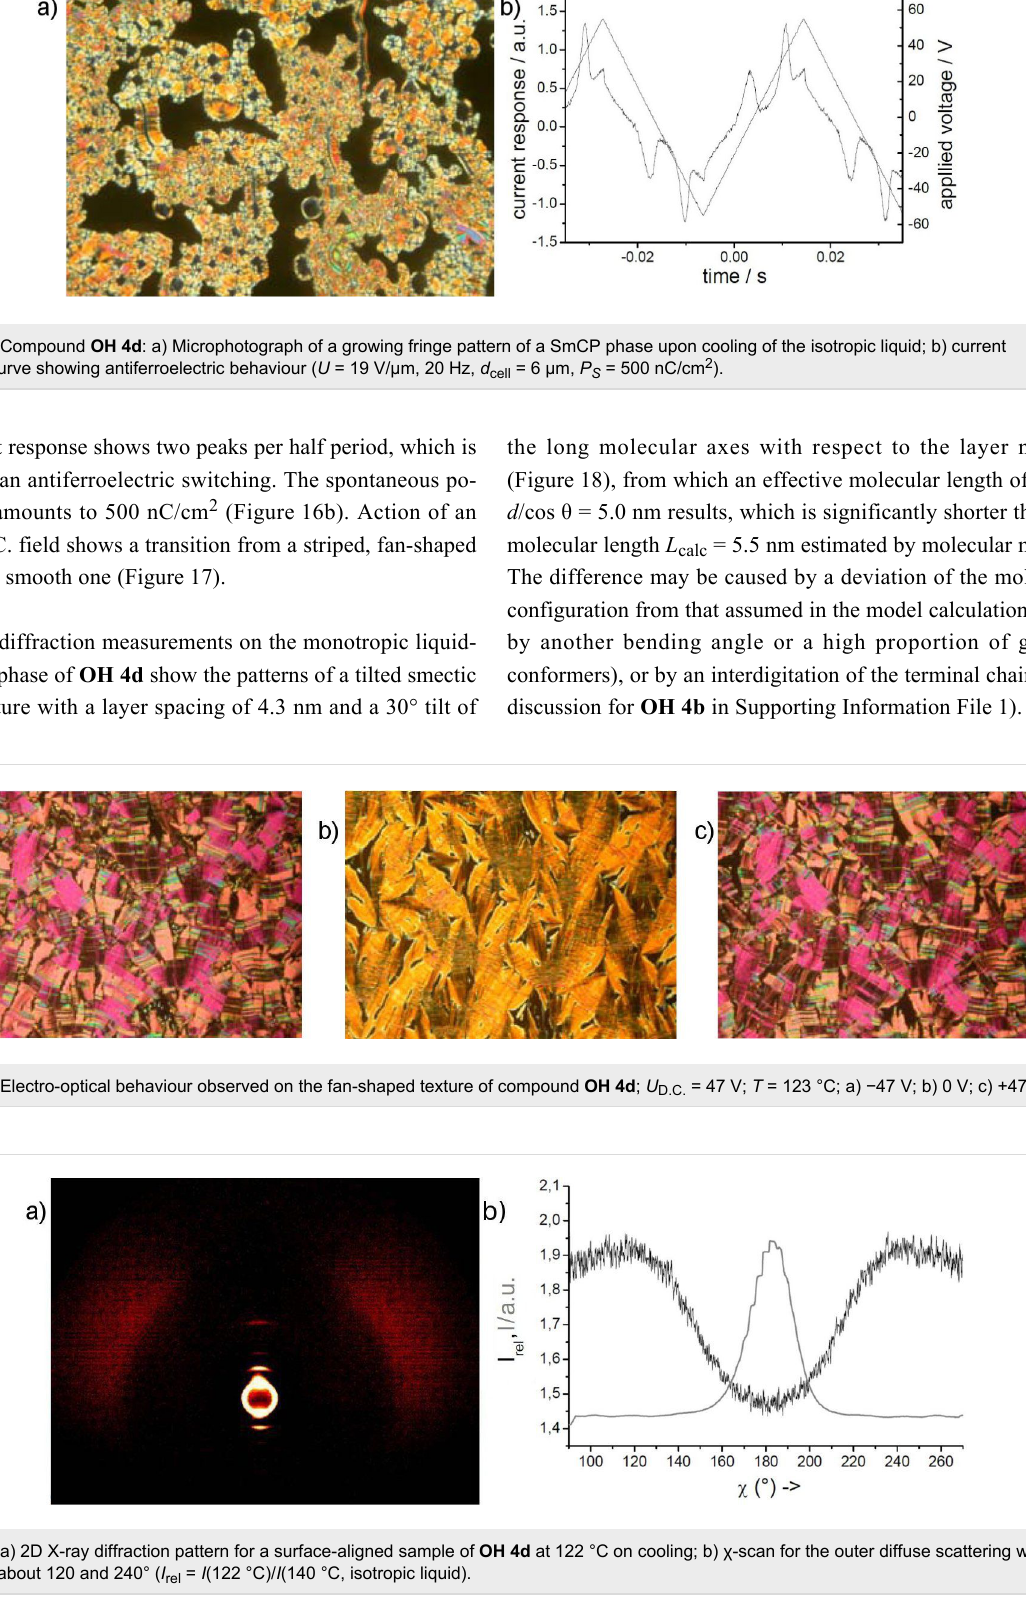
Figure 18: a) 2D X-ray diffraction pattern for a surface-aligned sample of OH 4d at 122 °C on cooling; b) χ -scan for the outer diffuse scattering with maxima at about 120 and 240° ( I rel = I (122 °C)/ I (140 °C, isotropic liquid).